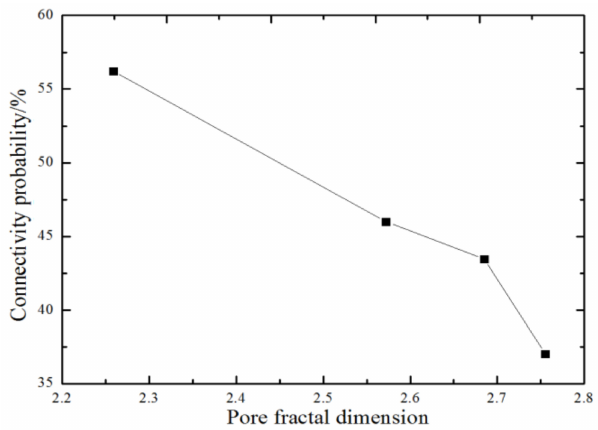
Figure 16. Relationship between connectivity probability of pores and pore volume dimension of 50~550